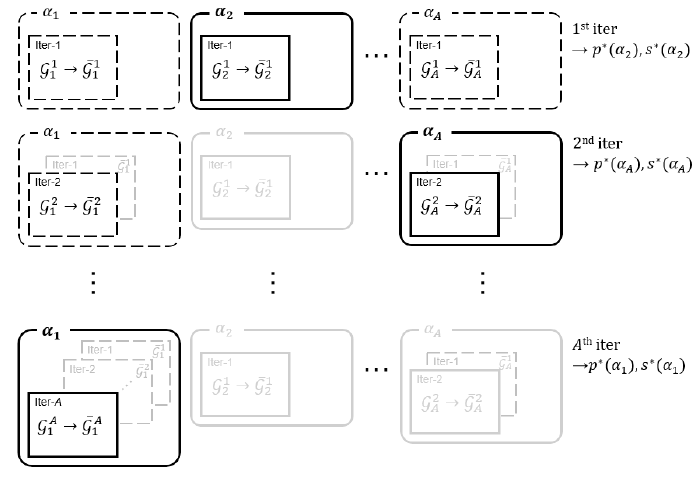
Figure 6. Iteratively generated airspace